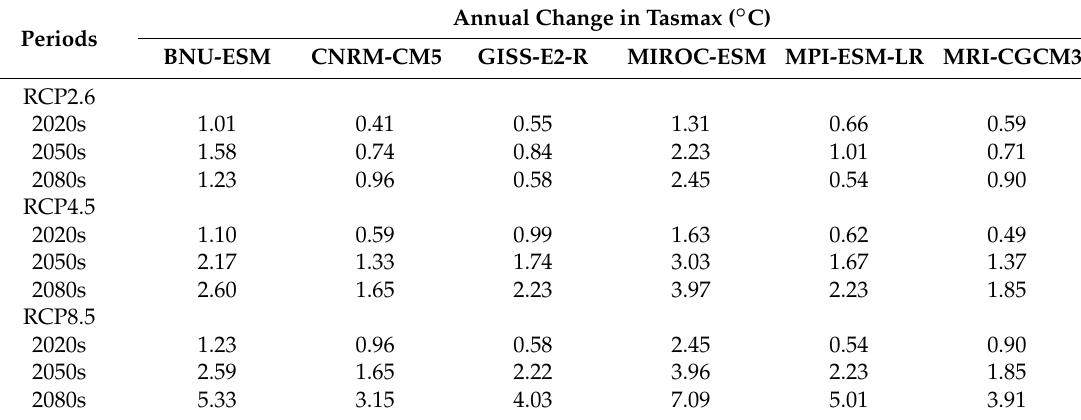
Table 7. Annual changes in tasmax ( ◦ C) for the future periods (2020s, 2050s and 2080s) under RCPs (RCP 2.6, RCP 4.5 and RCP 8.5). Annual Change in Tasmax ( ◦ C) Periods BNU-ESM CNRM-CM5 GISS-E2-R MIROC-ESM MPI-ESM-LR MRI-CGCM3 RCP2.6